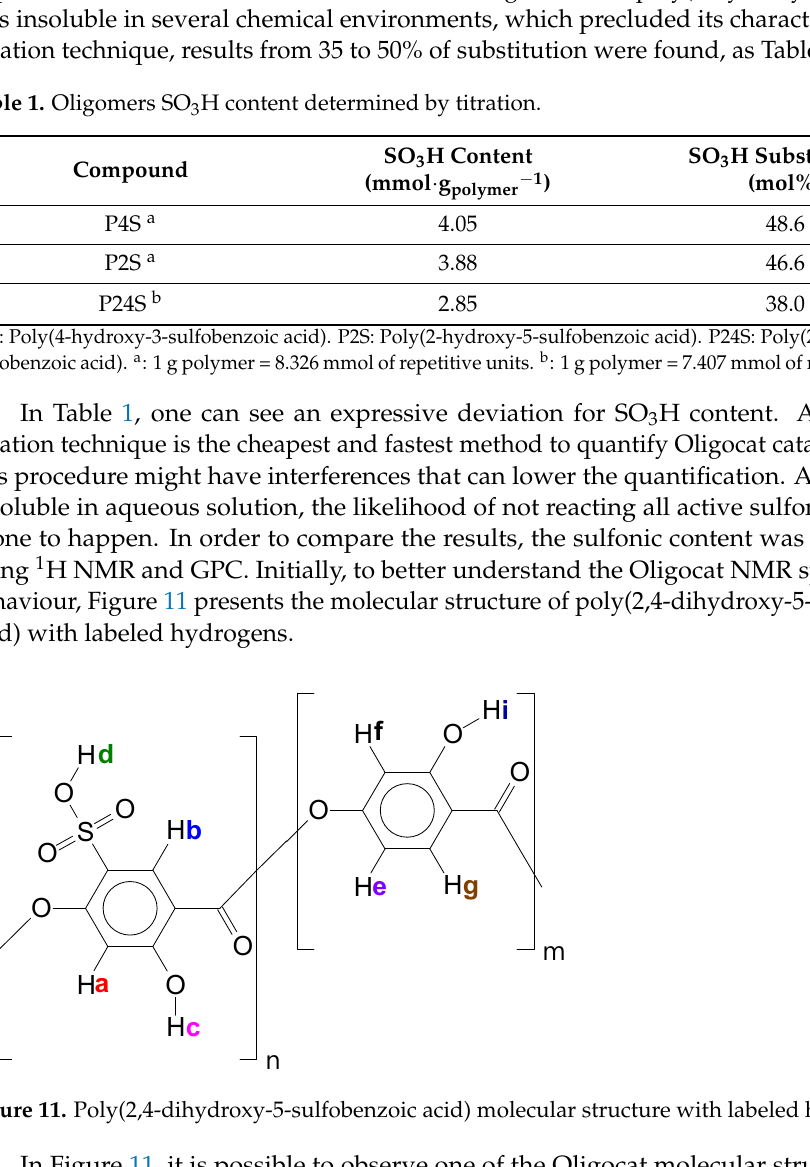
Table 1. Oligomers SO 3 H content determined by titration.